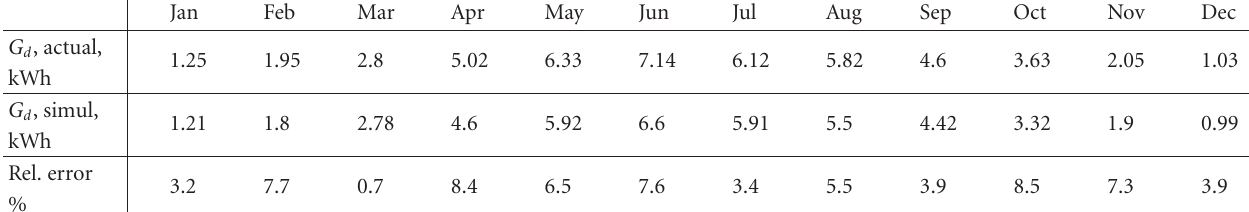
Table 1: Comparison between actual and simulated monthly average solar radiation data for Serres (Greece).